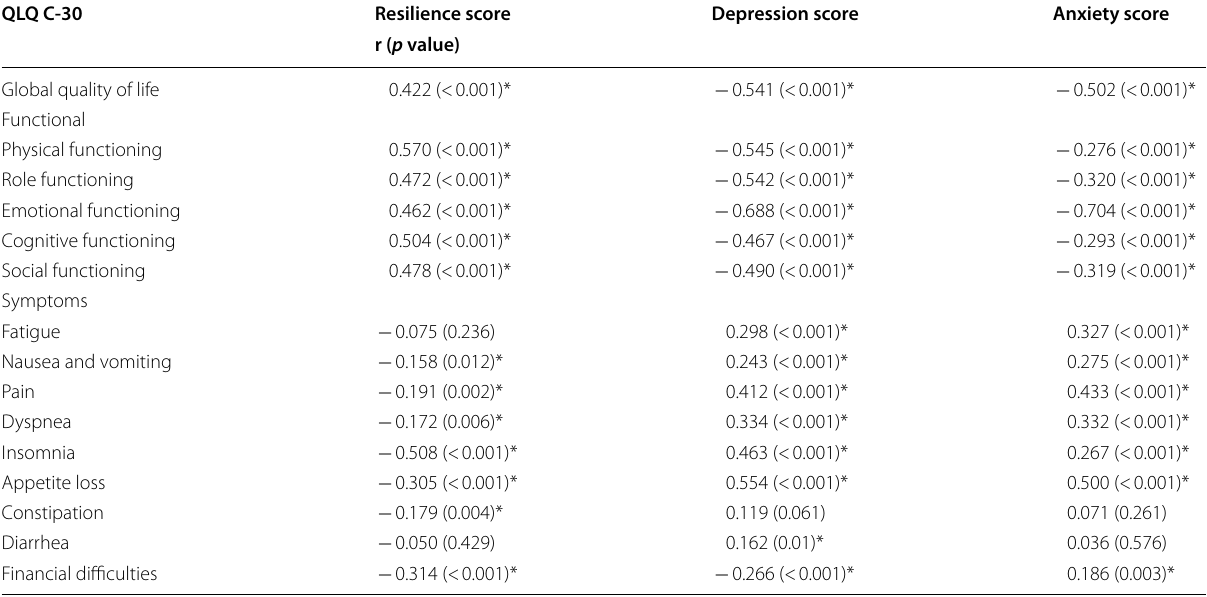
r Pearson correlation coefficient = *Significant at p value < 0.05